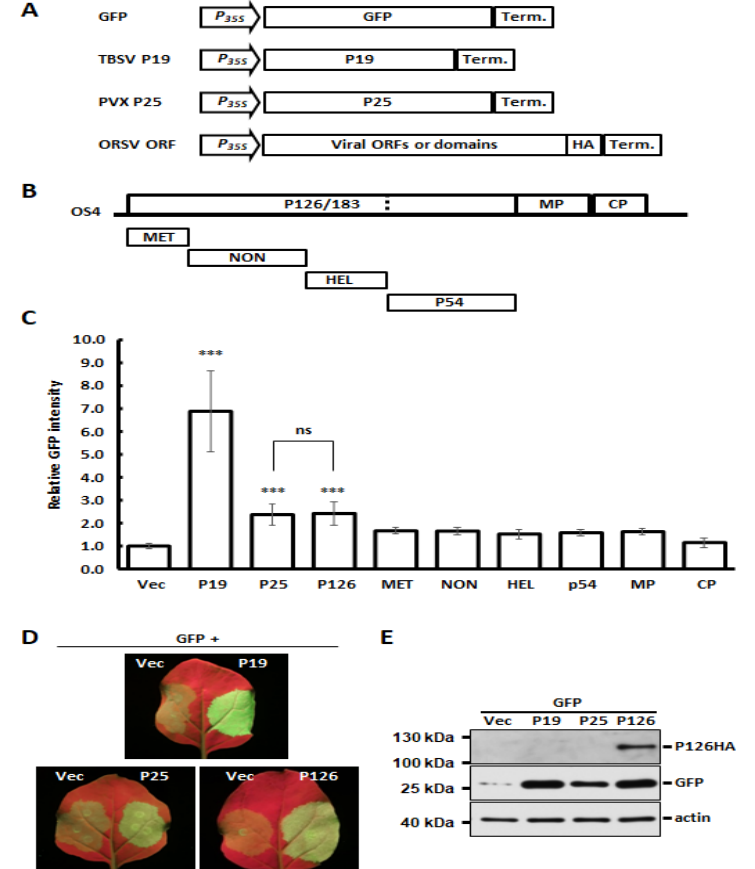
Figure 2. VSR assays of ORSV-encoded proteins and protein domains. ( A ) Schematics of expression cassettes for GFP (reporter), TBSV P19 and PVX P25 (VSR positive controls), as well as tested ORSV ORFs. ( B ) Individual ORFs and domains used for VSR assay. ( C ) Quantitative analysis of VSR activities. Overnight cultures of Agrobacterium carrying a corresponding plasmid were adjusted to final OD = 1. The co-infiltration of N. benthamiana leaves was performed by mixing Agrobacterium carrying pBIN61-GFP and Agrobacterium carrying plasmid positive for VSR or tested viral ORFs in a ratio of 1:1. GFP signals were detected and quantified using the IVIS Lumina III LT in vivo Imaging System at 4 DPA. Relative GFP intensity represents the mean of three independent experiments and was normalized to vector control. The significance was calculated by one-way ANOVA followed by post-hoc test and marked when p < 0.001 (***); ns: no significant difference. ( D ) Representative images of GFP signals as observed under hand-held UV lamp. ( E ) Accumulation of HA-tagged P126, GFP and actin in ( D ) was assessed by Western blotting by using antibodies against HA, GFP and actin,